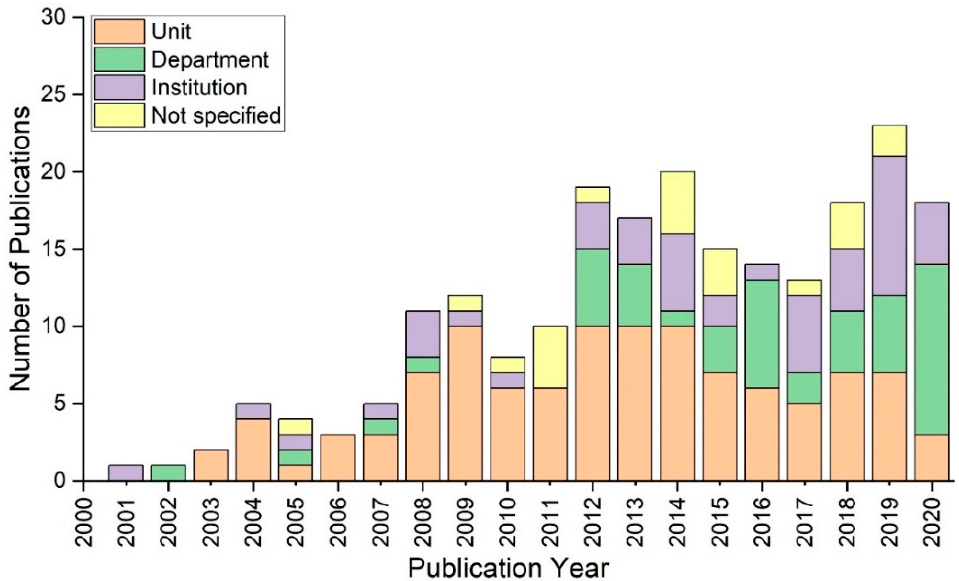
Figure 4. Number of studies carried out at the respective level of operational clinical environment between 2001 and 2020.